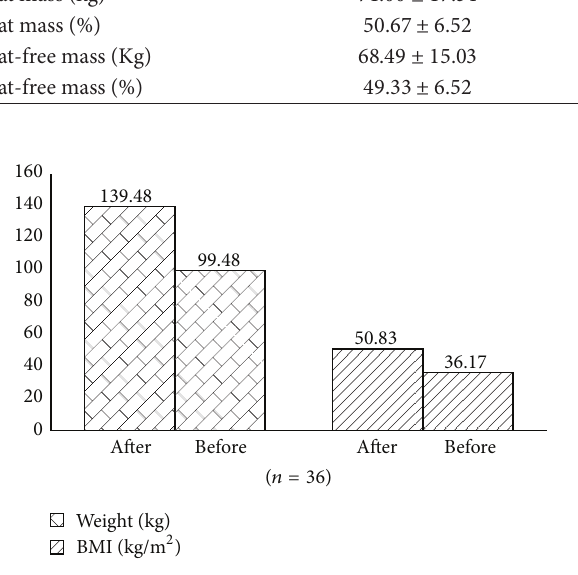
Figure 1: Weight and BMI before and six months after the bariatric